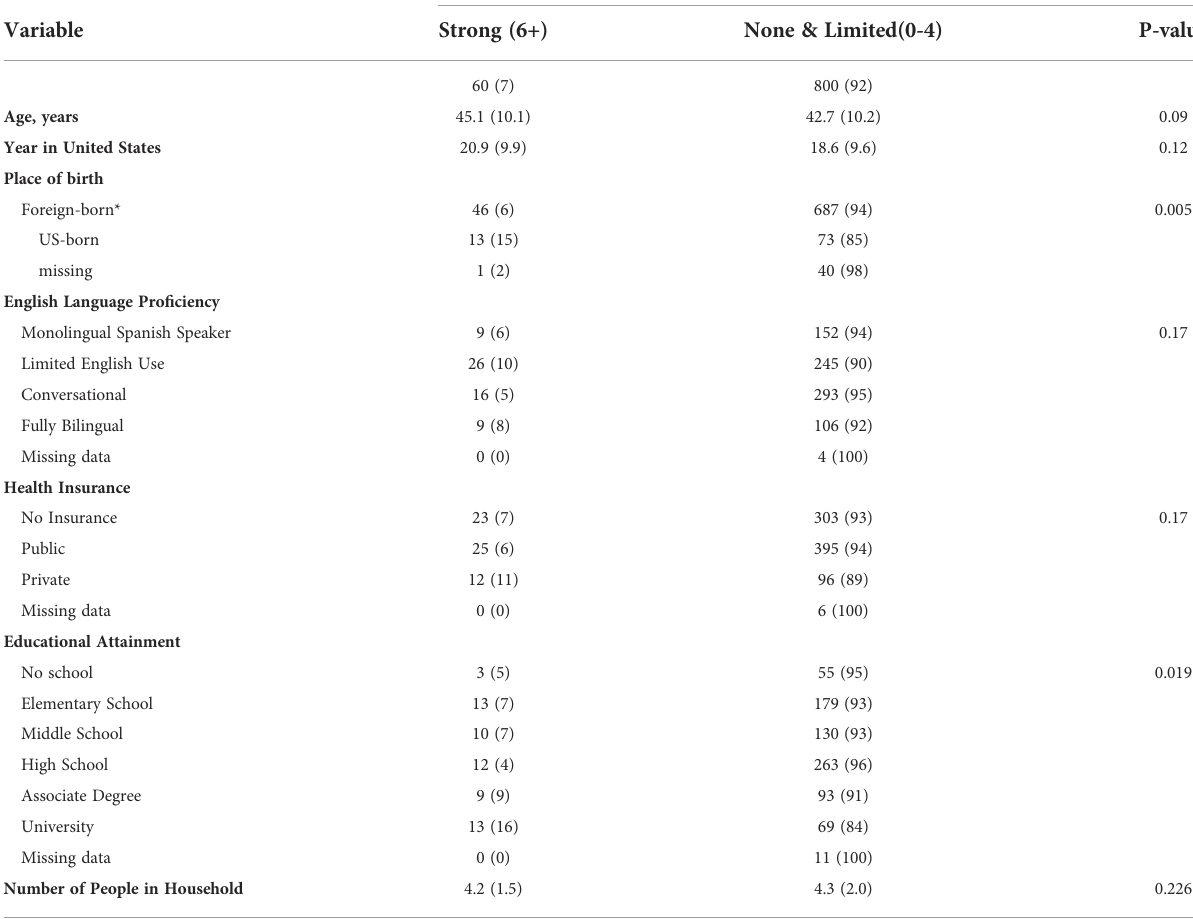
TABLE 8 Breast Cancer Family History among ‘ Tu Historia Cuenta ’ study participants by demographic